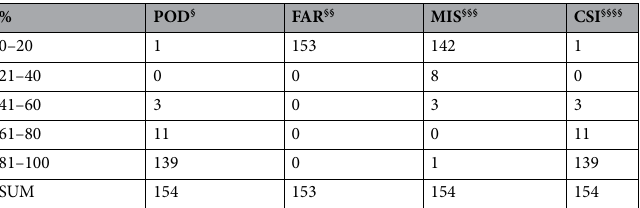
Table 1. Capacity of the MIMESIS-2 model to correctly model laboratory-confirmed human WNV cases. Included are the absolute number of municipalities from each of the examined indices (POD, FAR, MIS, CSI) and each accuracy zone. § POD = Hits /( Hits + Misses ) . §§ FAR = ( FalseAlarms )/( Hits + FalseAlarms ) . §§§ MIS = Misses /( Hits + Misses ) . §§§§ CSI = Hits /( Hits + FalseAlarms + Misses ) . with Hits (municipalities with cases both observed and simulated for a specific year), False alarms (municipalities with cases simulated but not observed for a specific year), and. Misses (municipalities with cases observed but not simulated for a specific year).